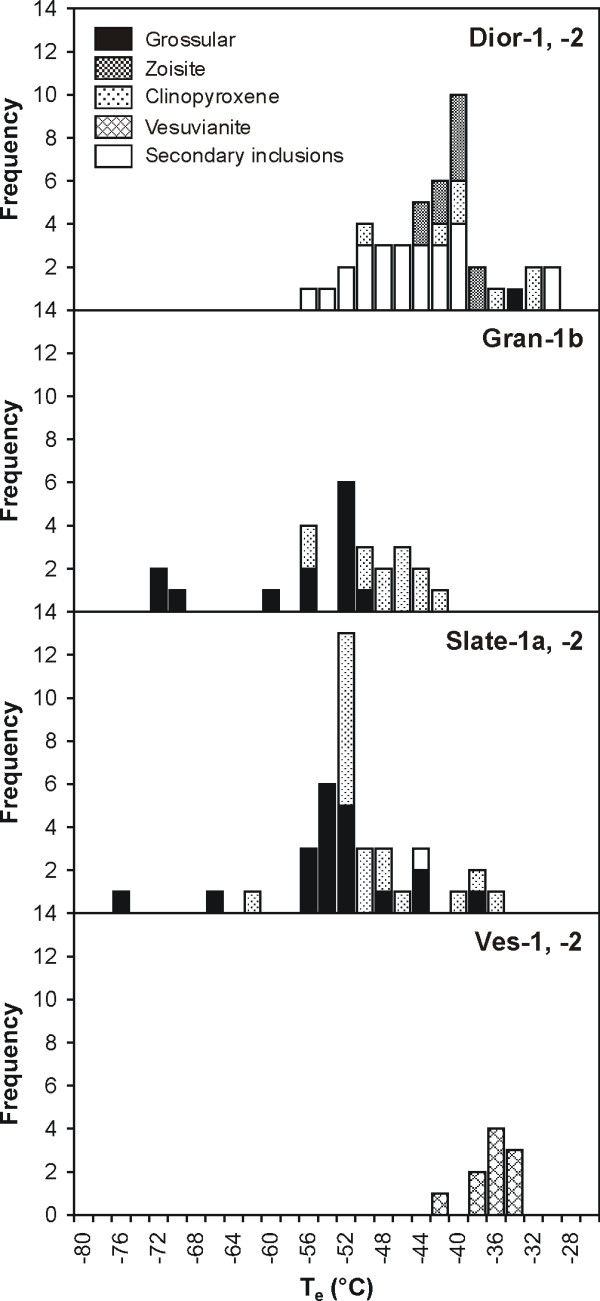
Histograms showing the distribution of the initial ice melting temperatures of type 2a and 2b fluid inclusions in rodingitized granite (Gran-1b), rodingitized slate (Slate-1a, -2), and rodingitized diorite (Dior-1, -2), and of type 2c fluid inclusions in vesuvianite from vesuvianite-rich veins (Ves-1, -2).